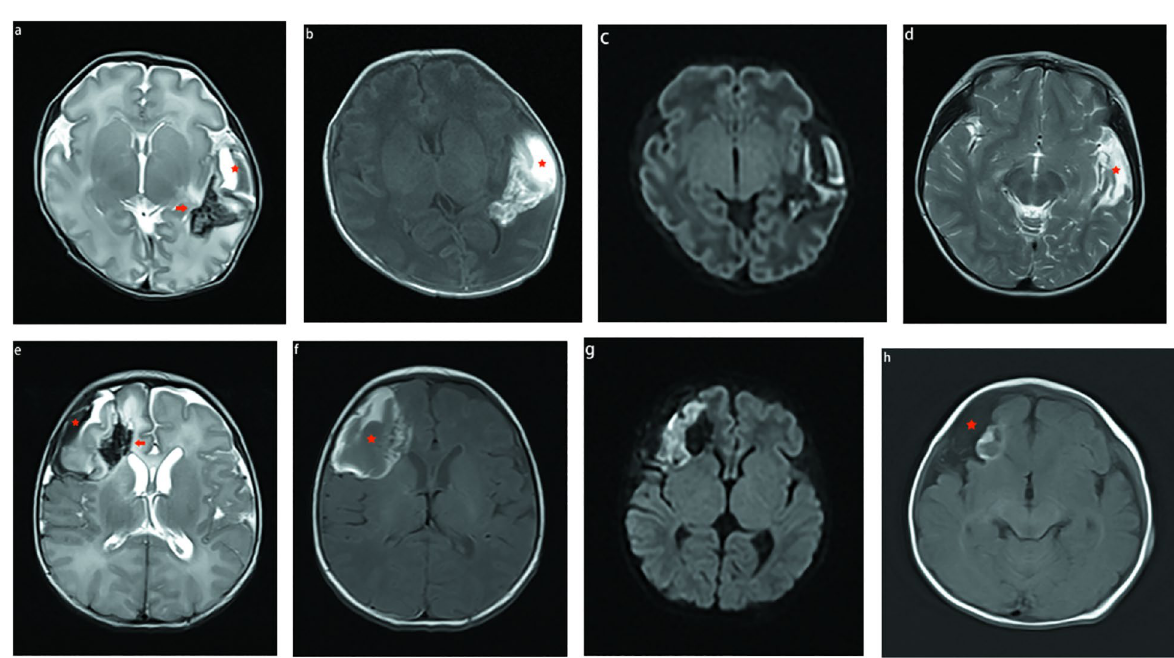
Figure 4. MR images of 2 neonates. The first patient ( a – d ) is a preterm neonate, and the second patient ( e – h ) is a term neonate. The first MRI shows ( a – c and e – g ) a subpial bleed (star), underlying the cerebral cortex and white matter with fan-shaped hemorrhage (arrow) created a sandwich sign. We found the medullary veins were notably enlarged (arrow in a and e ). Reexamination after 3 years ( d ) and 5 months ( h ) showed that the subpleural hemorrhage and cerebral parenchymal hemorrhage had been absorbed and eventually encephalomalacia and gliosis. Subpial cystic cavities were formed (red star in d and